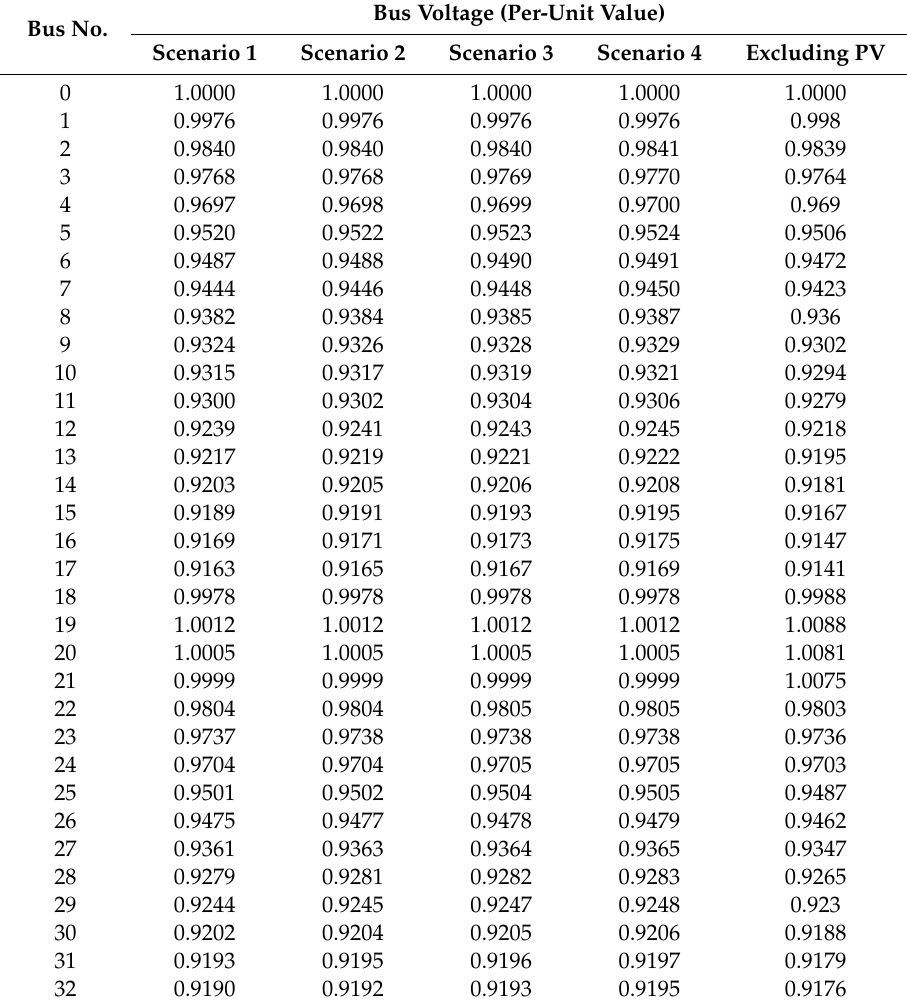
Table 2. Power subsystem bus voltage (per unit value) under di ff erent PV output scenarios. Bus